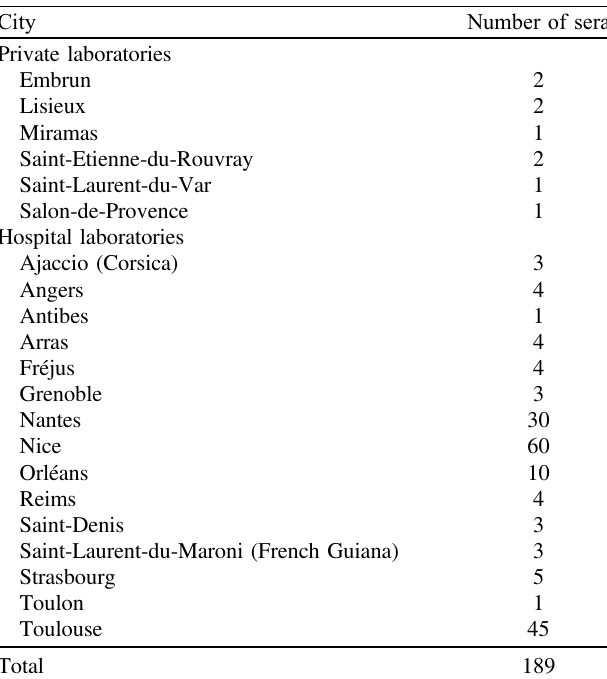
Table 1. Origin of the